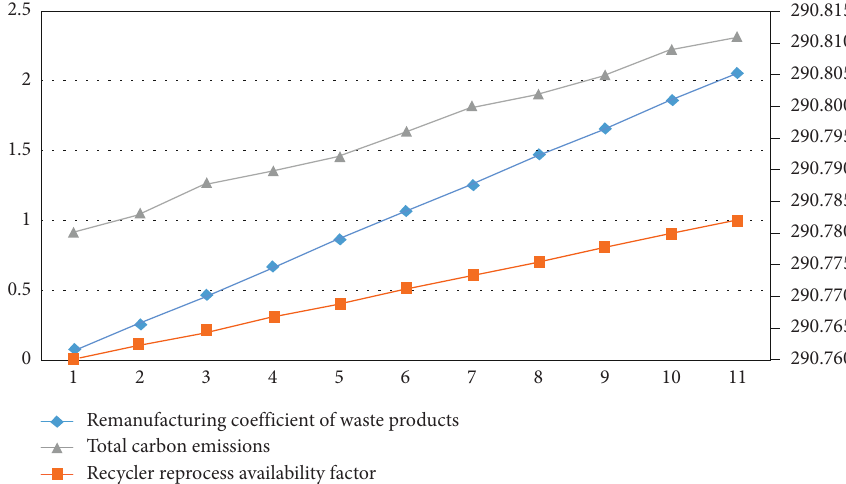
Figure 4: Change of total carbon emission with the remanufacturing coefficient μ of waste